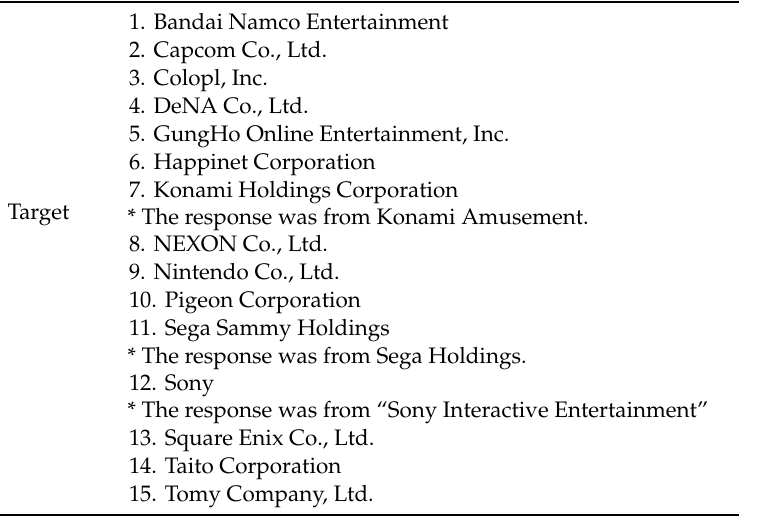
Table 2. Target of the survey.